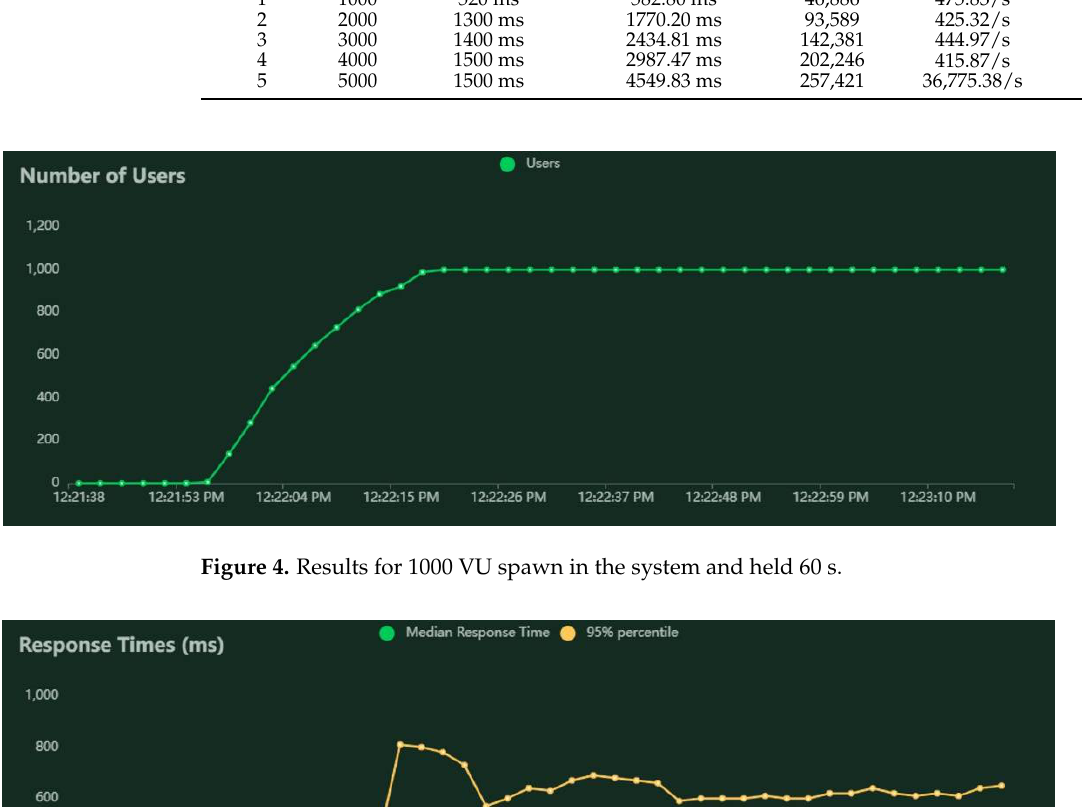
Figure 6. Requests per second and failure per second for 1000 VUs and 0-policy. To better visualize how the services perform under different policies, Figure 7 depicts a graph that shows the average response time against VUs for the three test cases men- tioned in Section 3.6. One can notice that the best average response time curve belongs to